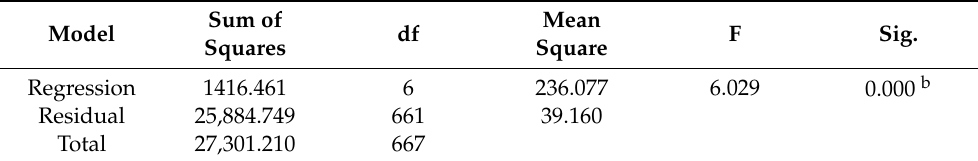
Table 6. Predictors for adjustment to pandemic using ANOVA a test. Mean Sum of F Sig. df Model Square Squares Regression 327.857 6 54.643 2.322 0.032 b Residual 15,558.017 661 23.537 Total 15,885.874